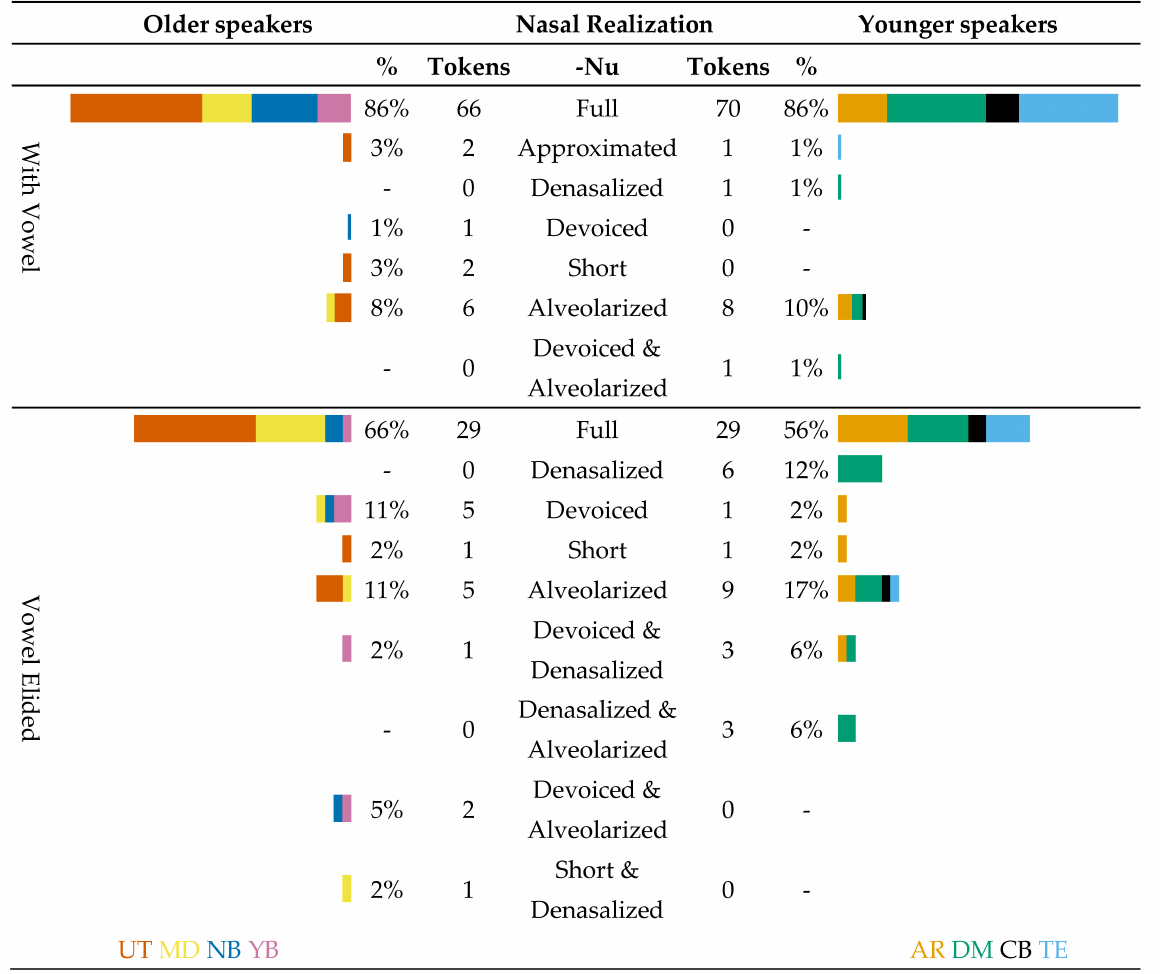
Figure 9. Realization of nasal when present. Above the line, vowel produced. Below the line, vowel not produced. Pre-stopping is not indicated here. Colors refer to individual speakers, ordered youngest to oldest, left to